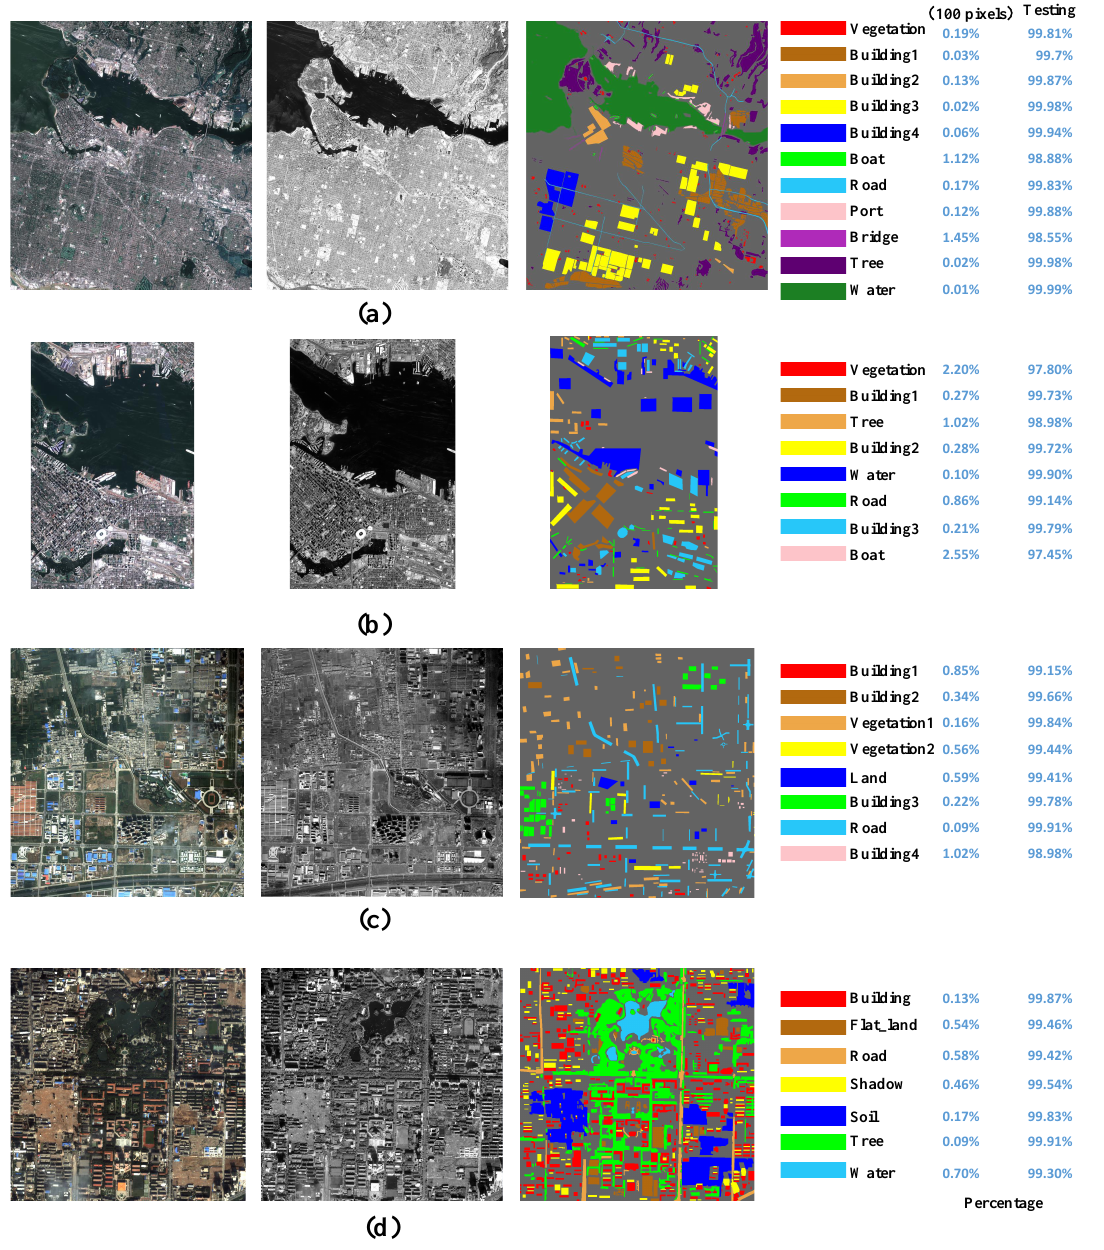
Figure 3. Datasets: ( a ) Level 1B dataset (from left to right: False color image of MS image, PAN image, ground-truth map, and class information) ( b ) Level 1C dataset. ( c ) Xi’an Suburban dataset. ( d ) Xi’an Urban